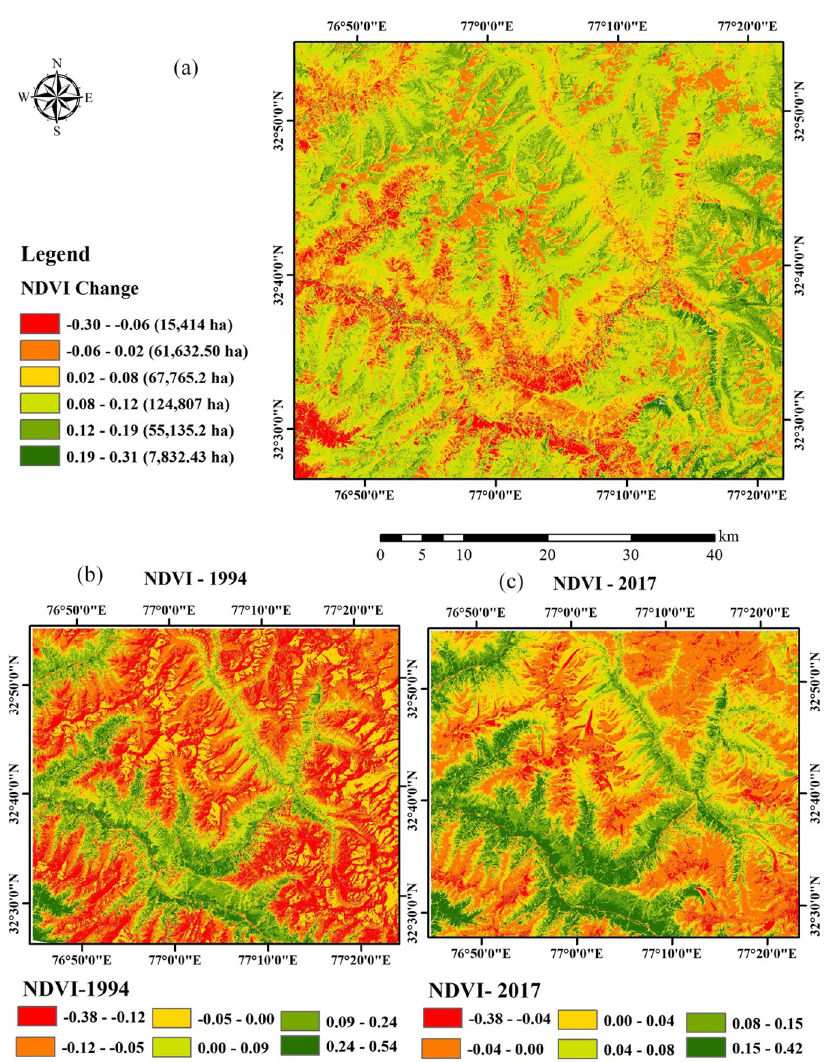
Figure 5. Diagram showing NDVI change detection map ( a ) and NDVI map of 1994 ( b ) and 2017 ( c ). In Figure a, the redder the color, the larger the decrease of NDVI. Similarly, the greener the color, the larger the greenness change.